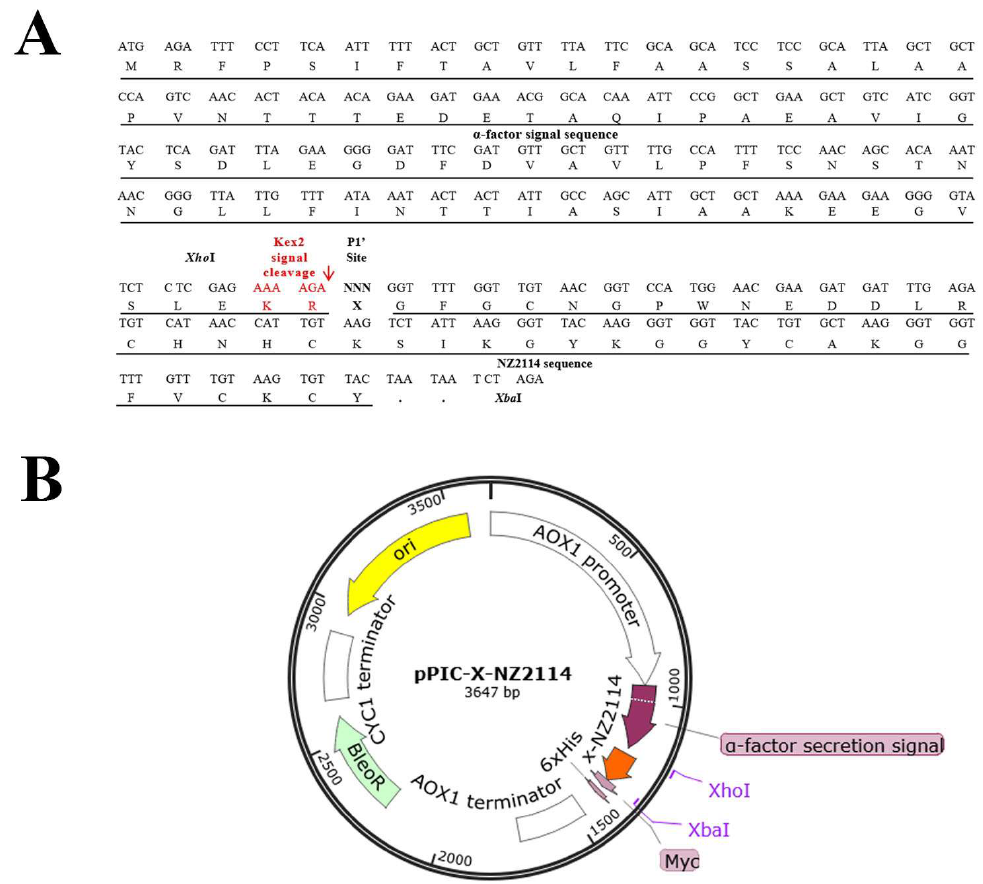
Figure 1. The construction of the pPIC-X-NZ2114 plasmid. ( A ) The amino acid sequence and corresponding nucleotide sequence of α -signal peptide and NZ2114. The α -factor signal is the α -MAT factor signal peptide from Saccharomyces cerevisiae . The X indicates 20 amino acids at the P1’ site, “NNN” represents the three bases that code for “X” in the P1’ site. The Kex2 enzyme signal recognition site is marked in red and the arrow represents the Kex2 signal cleavage site. ( B ) Schematic representation of the recombinant expression plasmid pPIC-X-NZ2114.